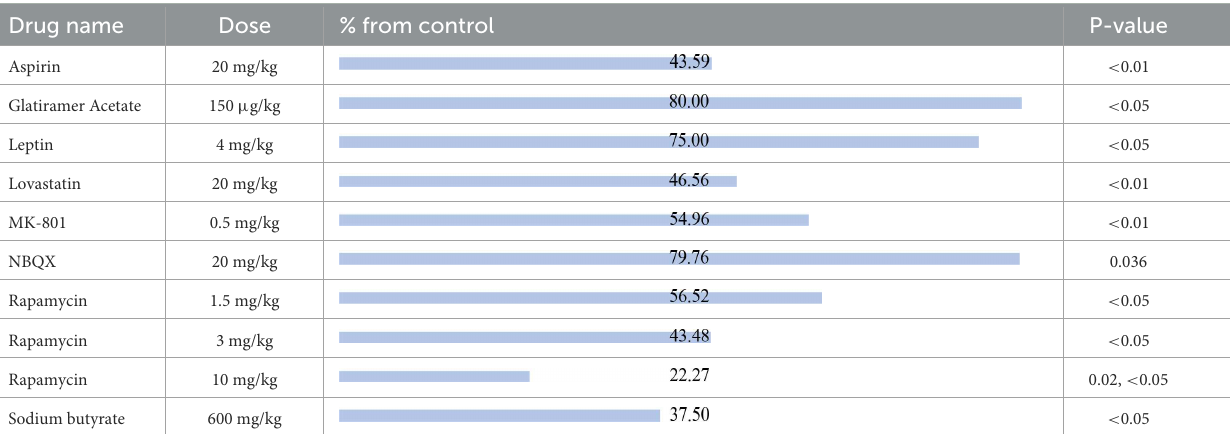
TABLE 6 Mossy fiber